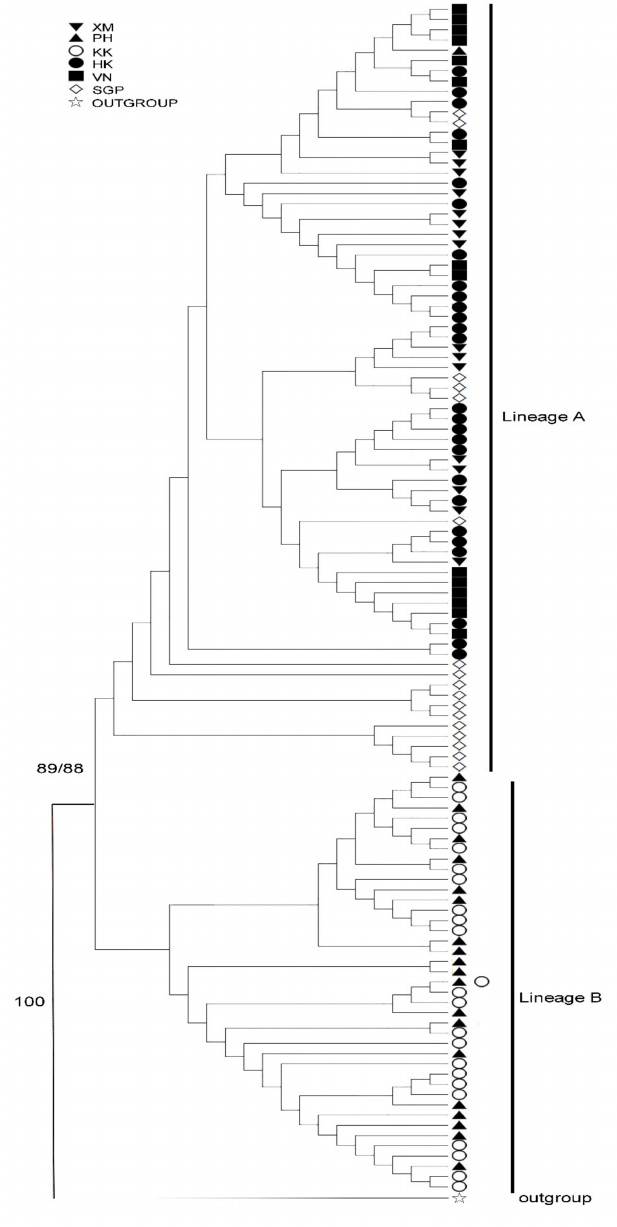
Figure 2. Neighbour-joining (NJ) tree based on mtDNA D-loop sequences with bootstrap values (NJ/ML, respectively) shown adjacent to the two corresponding lineages for Portunus pelagicus . The numbers at the nodes indicate bootstrap values (expressed as percentages) with 1000